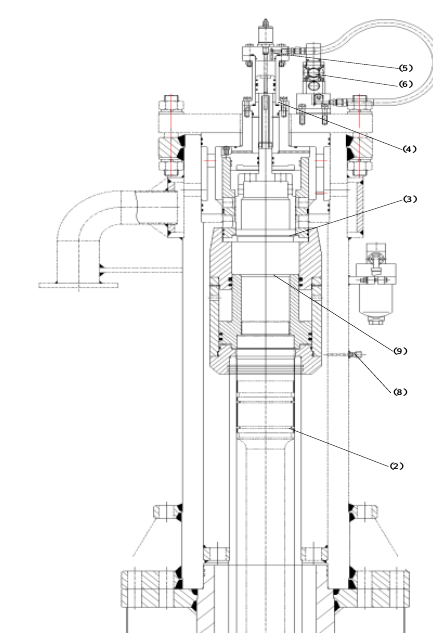
Figure 6. Schematic diagram of the main control valve.